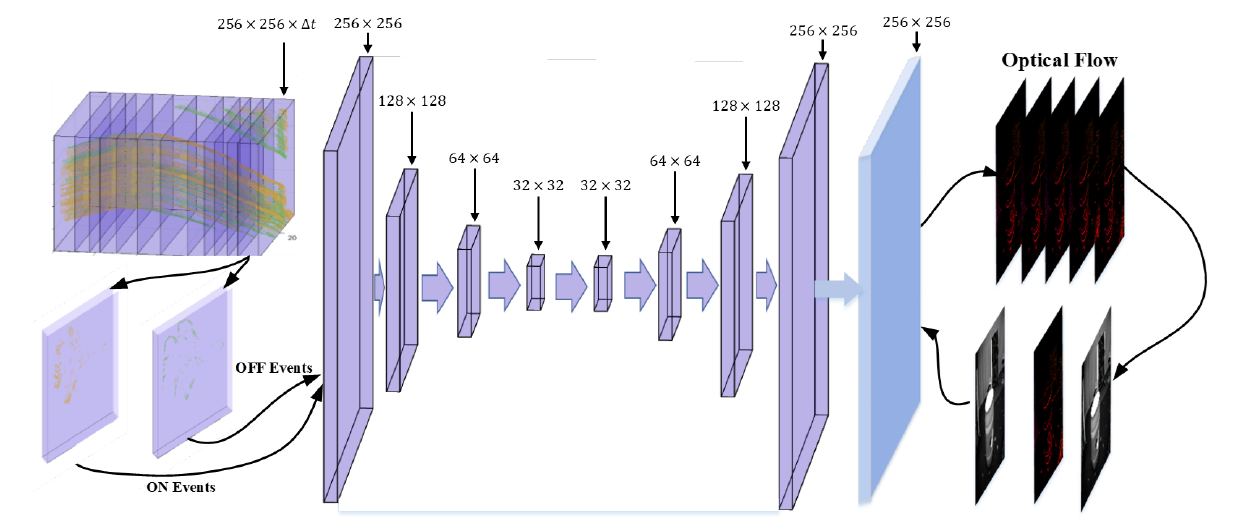
Figure 5. Spike neural network architecture for the event camera optical flow prediction. The events in the adaptive slice are divided into ON/OFF channels to enter the pyramid structure of the spike neural network in a discrete form, and the gray image is used to carry out spatio-temporal backpropagation in a self-supervised manner.